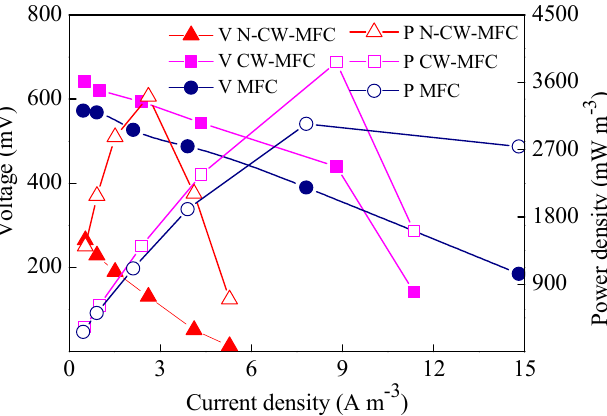
Figure 3. Polarization and power density curves for N-CW-MFC (constructed wetland integrated with microbial fuel cells of a blank carbon felt cathode), CW-MFC (constructed wetland integrated with microbial fuel cells of a MnO 2 -modified cathode), and MFC (microbial fuel cells of a MnO 2 -modified cathode). Modified carbon felt and blank carbon felt were analyzed with a scanning electron